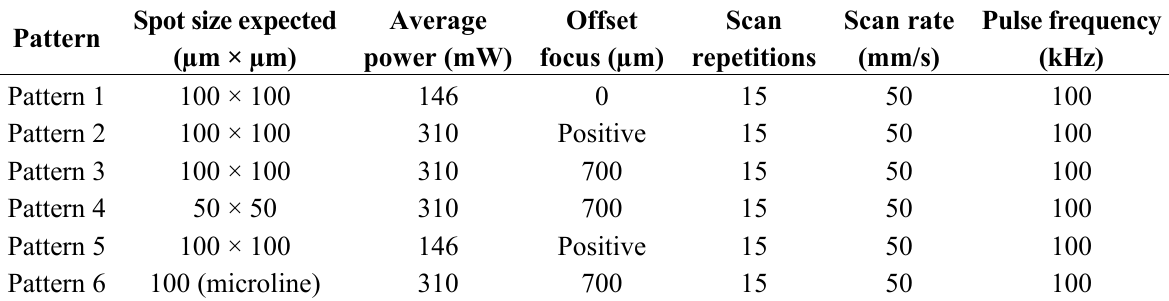
Table 1. Laser parameters used for the etching